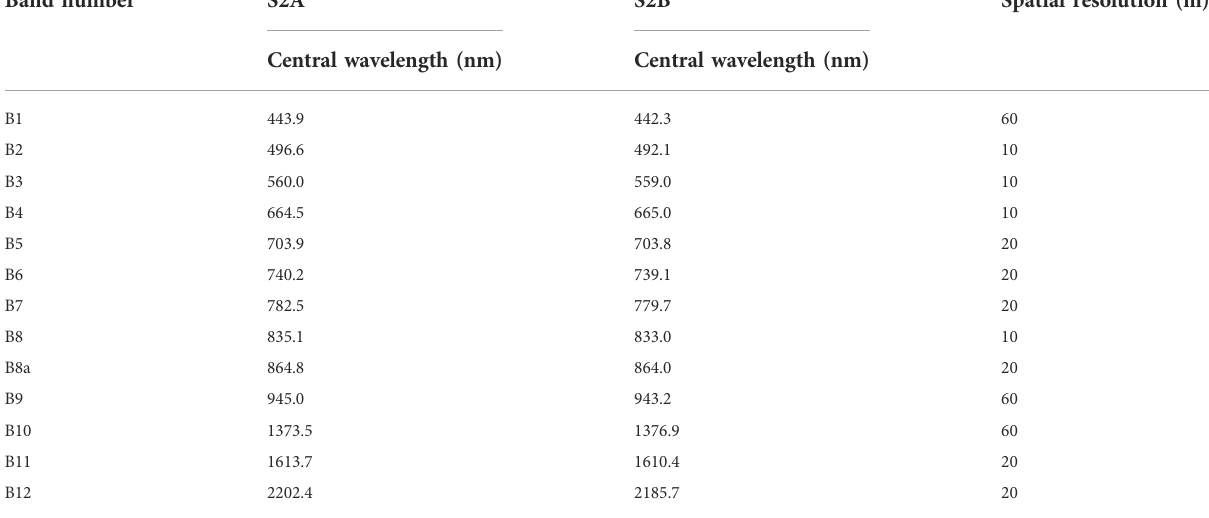
TABLE 2 Description of Sentinel-2 band